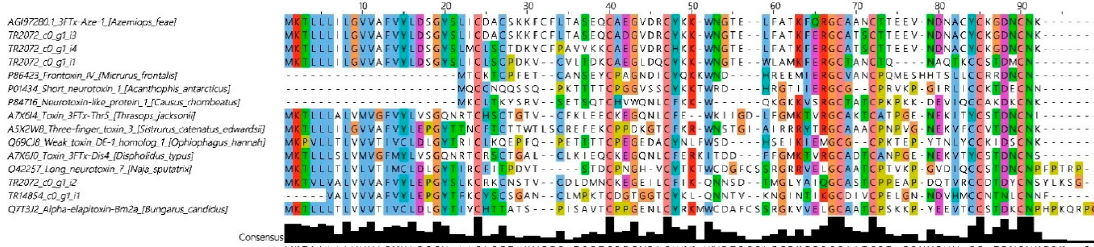
Figure 5. Three-finger toxins (3FTx). Comparison of amino sequences of A. feae toxins with those of known 3FTxs. TR2072 c0 g1 i3 is named 3FTx-Aze-2; TR2072 c0 g1 i4—3FTx-Aze-3; TR2072 c0 g1 i2—3FTx-Aze-4; TR14854 c0 g1 i1—3FTx-Aze-5; TR2072 c0 g1 i1—3FTx-Aze-6; TR13523 c0 g1 i1—3FTx-aze-7. Alignment was generated by MUSCLE with ClustalX Colour Scheme: hydrophobic amino acid residues—blue; positively charged—red; negatively charged—magenta; polar—green; cysteines— pink; glycines—orange; prolines—yellow; aromatic—cyan; unconserved—white.